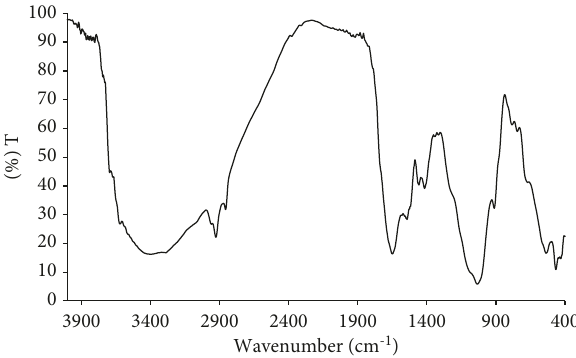
Figure 5: The FTIR spectra of the intact